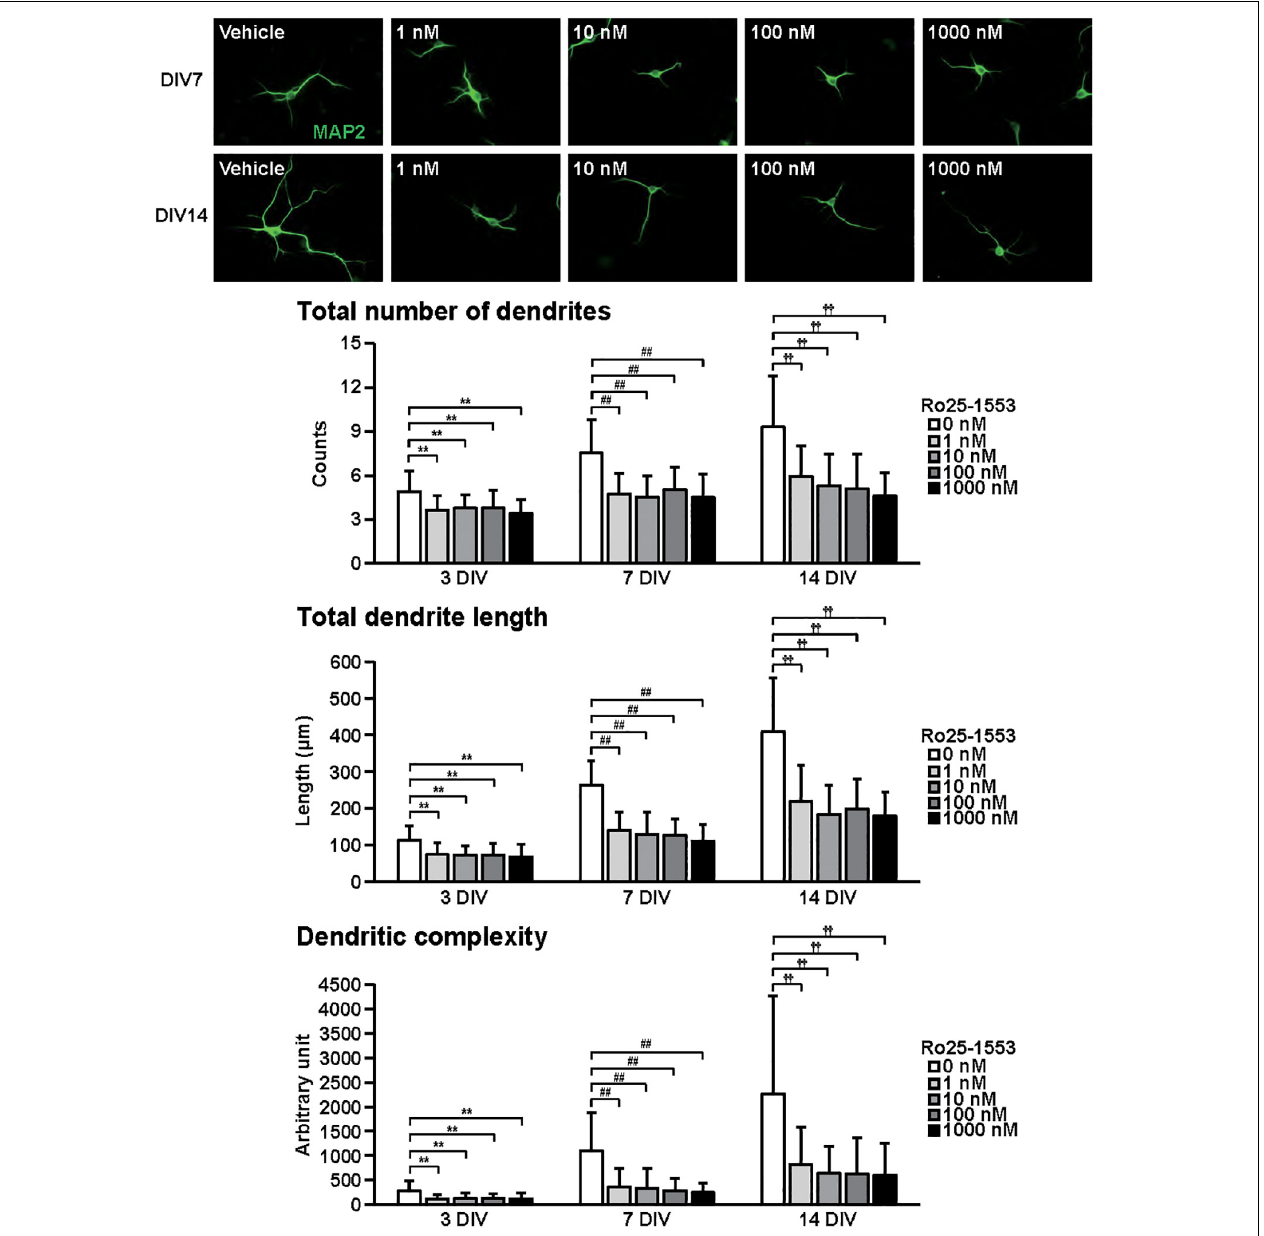
FIGURE 3 | Effects of Ro25-1553 on dendritic outgrowth in cultured cortical neurons. Representative MAP2 (green)-immunostained images of neurons cultured with Ro25-1553 (1–1000 nM) for 7 to 14 days in vitro (DIV) are shown. Quantitative analysis of dendritic morphology at 3 ( Figure 1B ), 7, and 14 DIV revealed that Ro25-1553 significantly decreased the total numbers (main effects: F 2 , 805 = 83.382, P < 0.0001 for time, F 4 , 805 = 75.612, P < 0.0001 for treatment; interaction: F 8 , 805 = 7.531, P < 0.0001) and length (main effects: F 2 , 805 = 323.212, P < 0.0001 for time, F 4 , 805 = 122.621, P < 0.0001 for treatment; interaction: F 8 , 805 = 17.981, P < 0.0001) of dendrites, and dendritic complexity (main effects: F 2 , 805 = 91.541, P < 0.0001 for time, F 4 , 805 = 49.193, P < 0.0001 for treatment; interaction: F 8 , 805 = 11.777, P < 0.0001). Values represent mean ± SD of 40–60 neurons from three independent experiments. ** P < 0.01, ## P < 0.01, †† P < 0.01 vs. control.